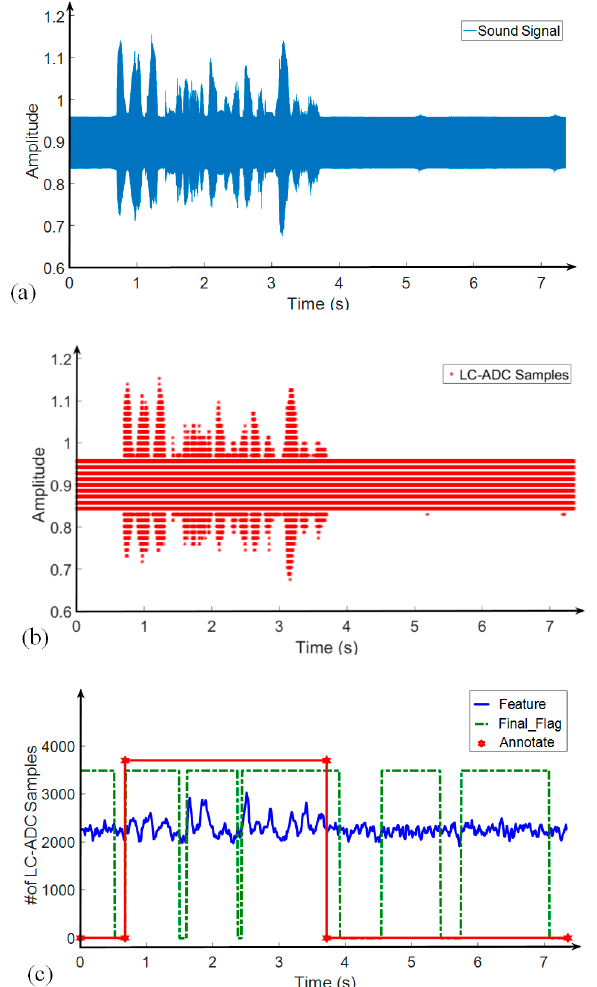
Figure 12. ( a ) The audio signal is contaminated with a lot of noise ( − 10 dB SNR and white noise). ( b ) A large number of samples are taken from the audio signal. ( c ) Excess speech detection due to high noise.